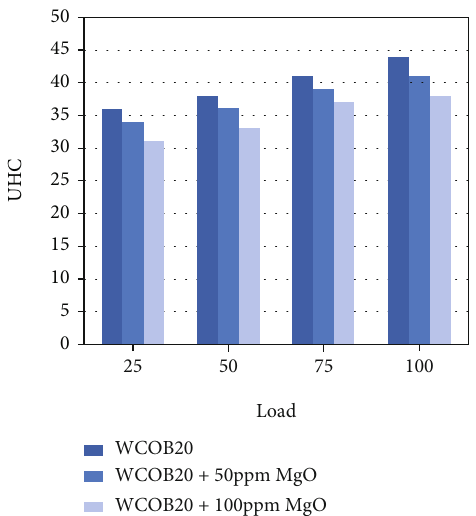
Figure 11: Hydrocarbon emission vs.